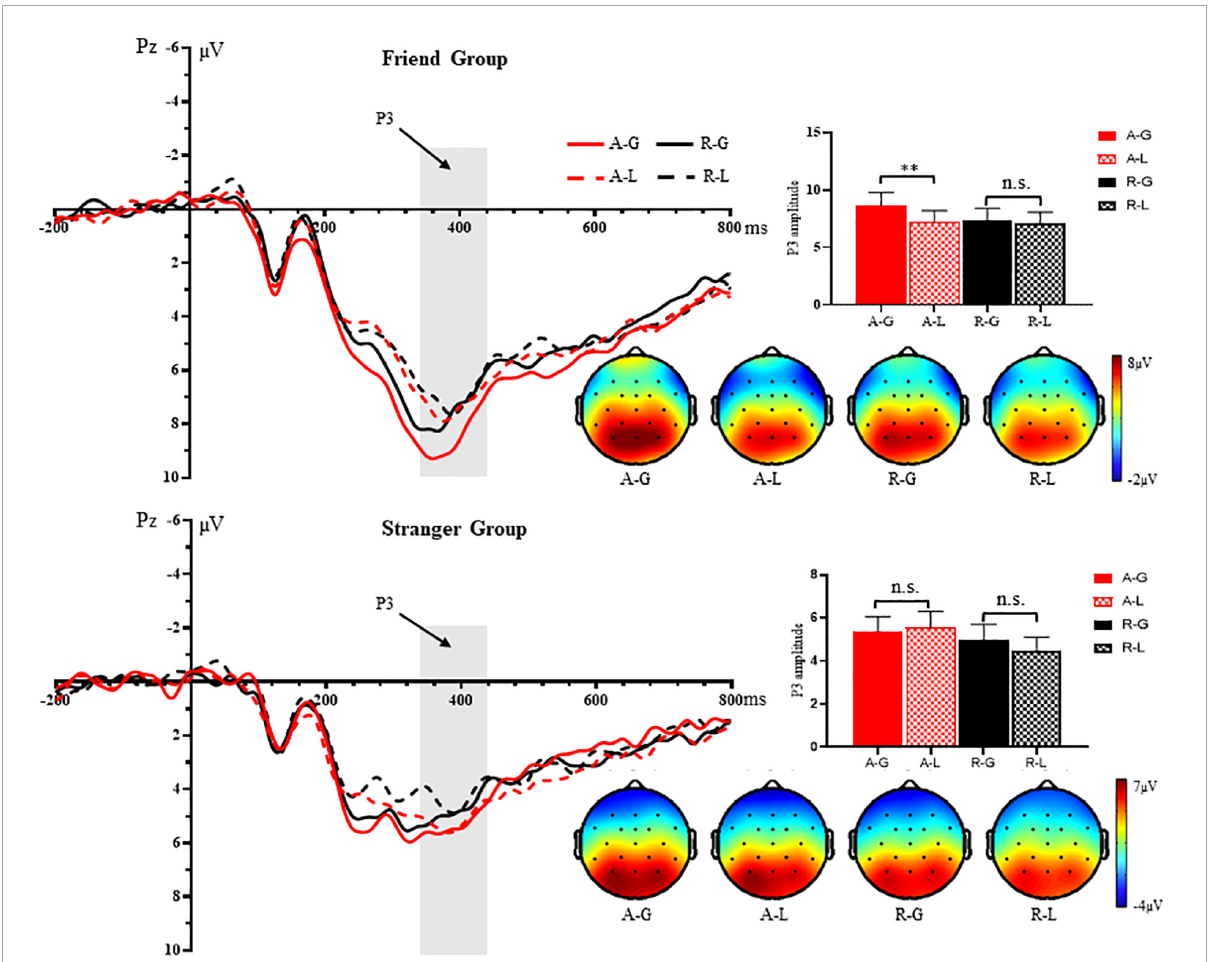
FIGURE3 Grand-averaged waveforms, amplitudes and topography from 340 to 440 ms at the Pz electrode in response to four combinations of outcome feedbacks following the advisee’s decisions: acceptance and receiving a gain (A-G), acceptance and receiving a loss (A-L), rejection